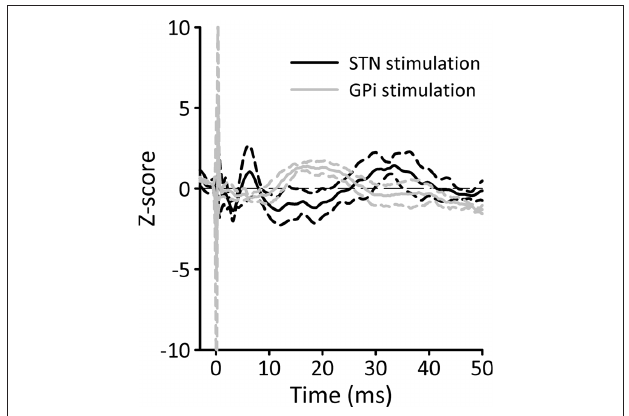
Figure 2 | Cortical potentials evoked by STN or gPi stimulation, recorded in an awake MPTP-treated primate. The animal was chronically implanted with two epidural EEG recording electrodes over the primary motor cortex. Single STN or GPi stimuli were delivered via a constant current source [SNEX-100 bipolar stimulation electrode (Rhoades Medical), biphasic stimulation, 10 Hz, 100 μs/phase, contact separation, 0.5 mm]. The figure shows EEG potential changes, averaged across 100 stimulation trials. The EEG was recorded with a differential montage between the two electrodes (filter settings 0.5–100 Hz). Prior to averaging, peri-stimulation EEG segments were aligned to the onset of stimulation (Time 0 ms). The solid lines represent the average response (black for STN and gray for GPi) and the dashed lines correspond to